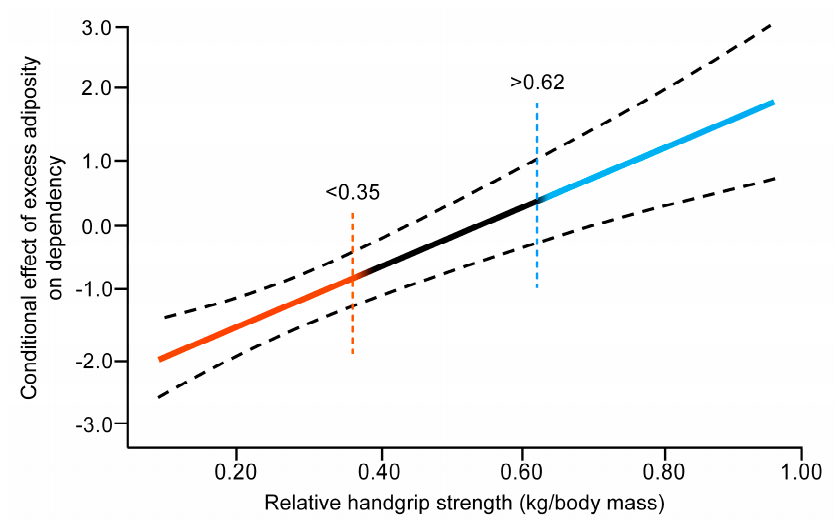
Figure 2. Regression slope estimate and 95% confidence intervals for the relationship between Figure2. Regressionslopeestimateand95%confidenceintervalsfortherelationshipbetweenmoderator moderator variable (relative handgrip strength) and adverse effect of WHtR levels on dependency variable (relative HGS) and adverse e ff ect of WHtR levels on dependency level in activities of daily living level in activities of daily living (ADL), based on the Johnson–Neyman procedure. Red line indicates (ADL), based on the Johnson–Neyman procedure. Red line indicates negative region of significance negative region of significance at moderator value (< 0.35 of relative handgrip strength). Blue line at moderator value ( < 0.35 of relative HGS). Blue line indicates the positive region of significance at indicates the positive region of significance at moderator value (> 0.62 of relative handgrip strength). moderator value ( > 0.62 of relative HGS). Black line represents neutral region of Black line represents neutral region of significance.